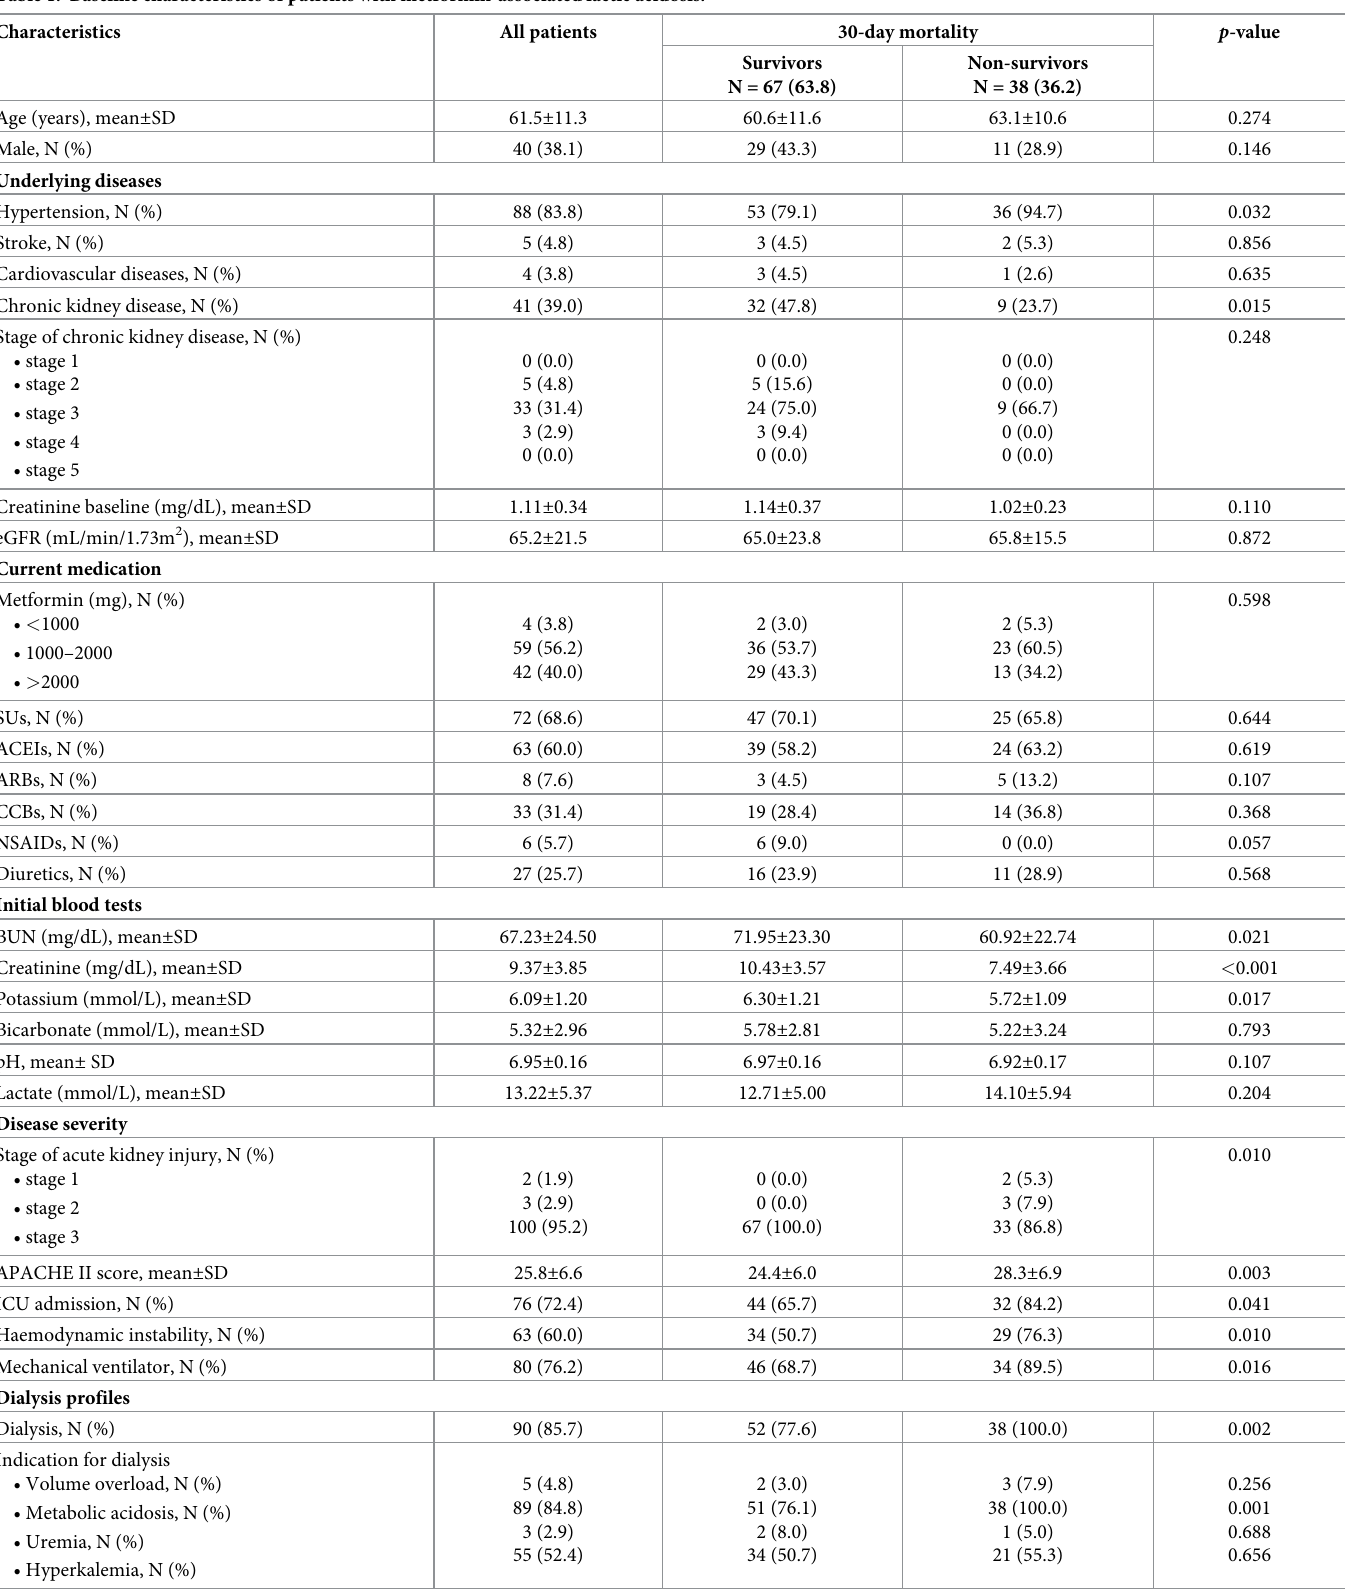
Table 1. Baseline characteristics of patients with metformin-associated lactic acidosis.